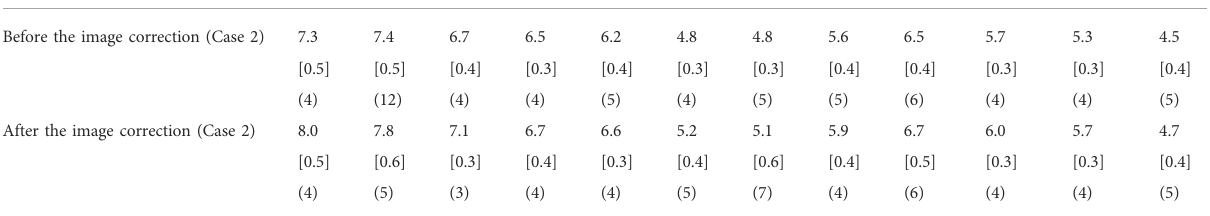
TABLE 3 Analyzed angles in Case 2 before and after image correction with projective transform.